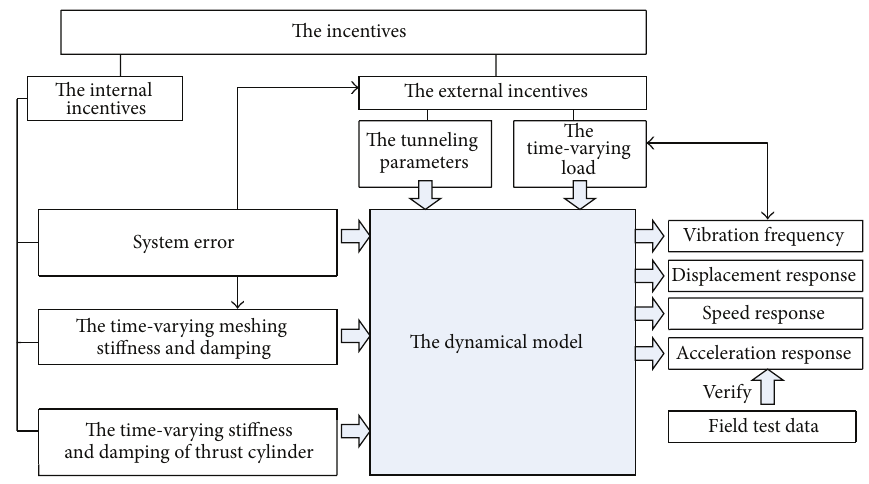
Figure 1: Research